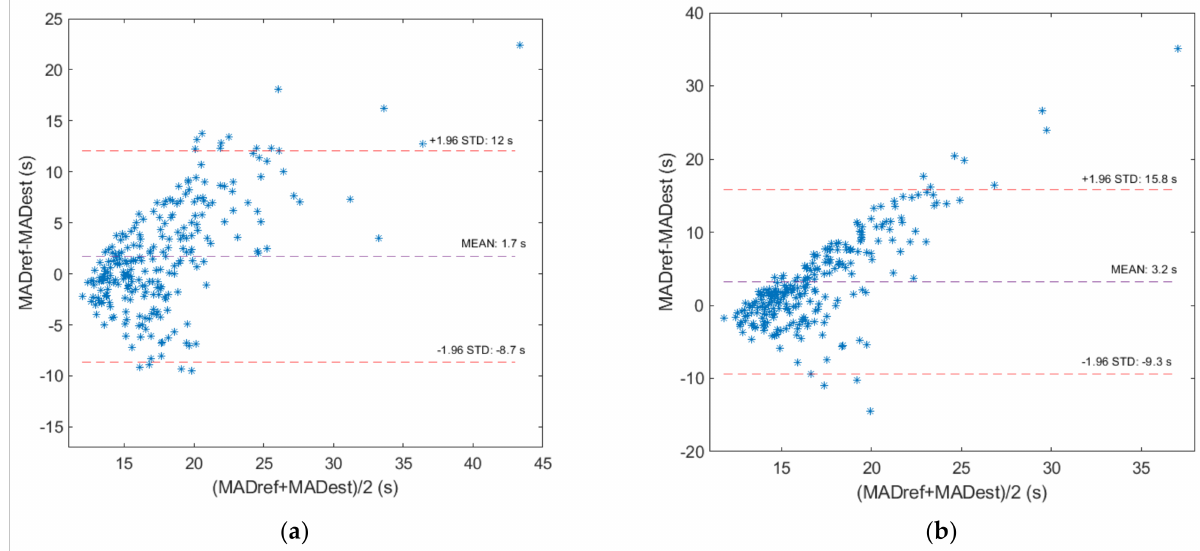
Figure 6. Bland-Altman diagrams for the reference and estimated Mean Apnea Duration (MAD) index for all patients of the dataset: ( a ) based on tracheal sound recordings; ( b ) based on ambient sound